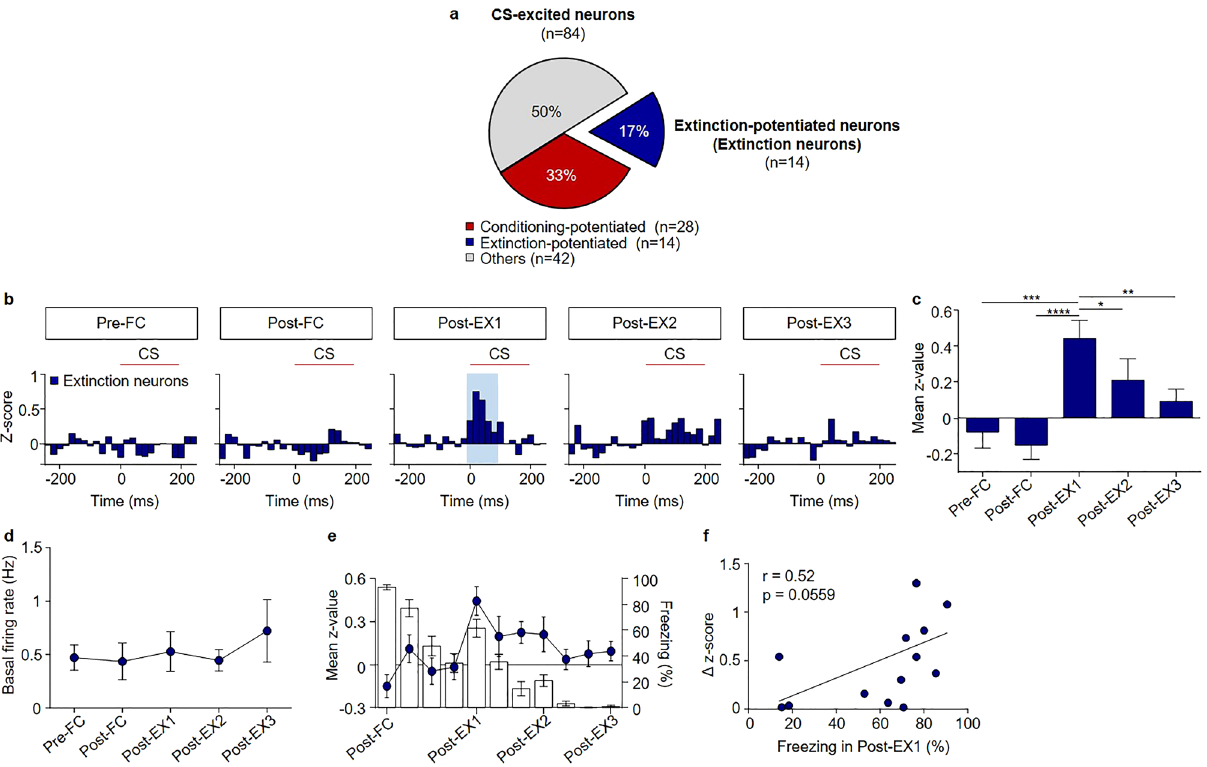
Figure 5. Extinction neurons encode the early phase of fear extinction. ( a ) Pie chart showing the percentage of extinction neurons among the CS-excited neurons. ( b ) Z-score PETH of extinction neurons (n = 14, 17% of CS-excited neurons). ( c ) Mean z-score comparisons of extinction neurons. ( d ) Comparison of the basal firing rates of extinction neurons across all behavioral sessions. ( e ) Averaged time courses of freezing responses and neuronal activity (z-scores) of extinction neurons. ( f ) Correlation analysis between the neural responses and freezing behavior in Post-EX1. A positive trend was observed (r = 0.52, p = 0.0559). * p < 0.05; ** p < 0.005; *** p < 0.0005; **** p < tion ( p > 0.05 for Post-EX2 or Post-EX3 vs. Pre-FC, p = 0.0106 for Pre-FC vs. Post-EX1). This population of BA L neurons is similar to the fear neurons found among CS-excited neurons. Extinction-inhibited neurons (n = 8, from 7 rats, 27% of CS-inhibited neurons; Fig. 6a, c), which showed no significant inhibitory activity in Pre-FC and Post-FC, showed significant inhibitory responses to the CS in Post-EX1 ( χ 2 = 14.40, p = 0.0061, p < 0.05 for Pre-FC and Post-FC vs. Post-EX1; Friedman test followed by Dunn’s test; Fig. 6e). The CS-evoked inhibitory activities disappeared after the second session of extinction ( p > 0.05 for Post-EX2 or Post-EX3 vs. Pre-FC). This sub-population of BA L neurons is similar to the ‘extinction neurons’ found among CS-excited neurons. The average spontaneous firing rate was 1.717 ± 0.2572 Hz for conditioning- inhibited neurons and 0.6630 ± 0.09192 Hz for extinction-inhibited neurons. The spontaneous firing rates of conditioning-inhibited neurons were higher than extinction-inhibited neurons before and after fear condition- ing ( p < 0.05 for Pre-FC and Post-FC, Mann–Whitney test; Fig. 6f). These findings suggest that BA L neurons, which show inhibitory responses to the CS, also modify their responses to the CS during fear conditioning and extinction, similar to the CS-excited neurons. Subsequently, we compared the averaged time courses of the CS-evoked activity of the conditioning-inhib- ited and extinction-inhibited neurons with freezing during the extinction of conditioned fear (Supplementary Fig. S3a, b). The averaged time course of the CS-evoked activity of conditioning-inhibited neurons was similar to that of freezing during extinction (Supplementary Fig. S3a). In contrast, extinction-inhibited neurons showed enhanced CS-evoked activity only in Post-EX1 (Supplementary Fig. S3b). CS-responses of conditioning-inhibited neurons and extinction-inhibited neurons changed similarly to those of fear neurons and extinction neurons, respectively, throughout the behavioral training. Additionally, we compared the CS-evoked activity of individual neurons in Post-EX1 with freezing in Post- EX1 to determine whether the magnitude of the activity changes of the individual BA L neurons correlate with behavioral changes after extinction (Supplementary Fig. S3c, d). The activity changes of conditioning-inhibited neurons showed a positive trend with freezing in the recorded rats (Supplementary Fig. S3c; r = 0.76, p = 0.0746, Pearson’s correlation), whereas those of extinction-inhibited neurons showed a negative trend with freezing (Supplementary Fig. S3d; r = -0.40, p = 0.3326, Pearson’s correlation). Together, the responses of BA L neurons which are inhibited by the CS are dynamically modified throughout fear conditioning and extinction, suggesting CS-inhibited neurons are also actively involved in fear learning and extinction.